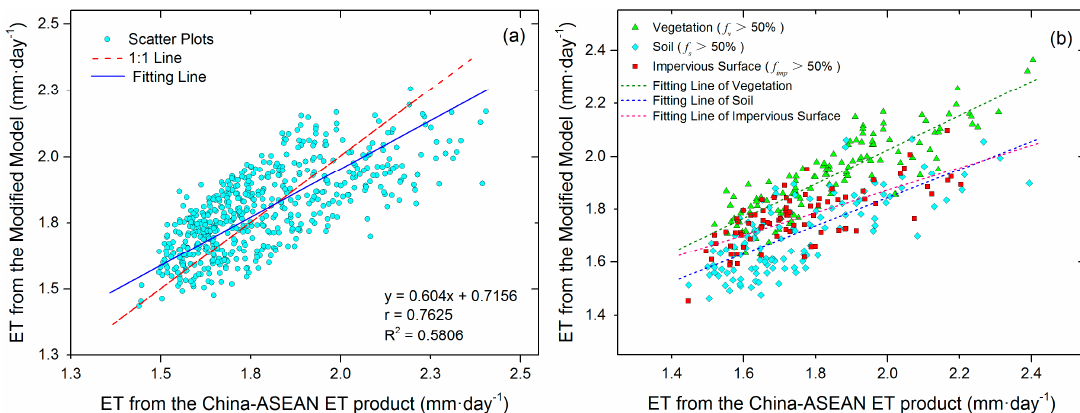
Figure 13. ( a ) Scatter plot of the modified model derived ET against the China–ASEAN ET product, based on the entire 552 sampled points; ( b ) scatter plot of the modified model derived ET against the China–ASEAN ET product, for each land cover (124 sampled points for vegetation, 130 for soil, and 102 for impervious surfaces). Table 7. Linear relationship between our modeled ET and the China-ASEAN ET product for each land cover type (vegetation, soil, and impervious surfaces).